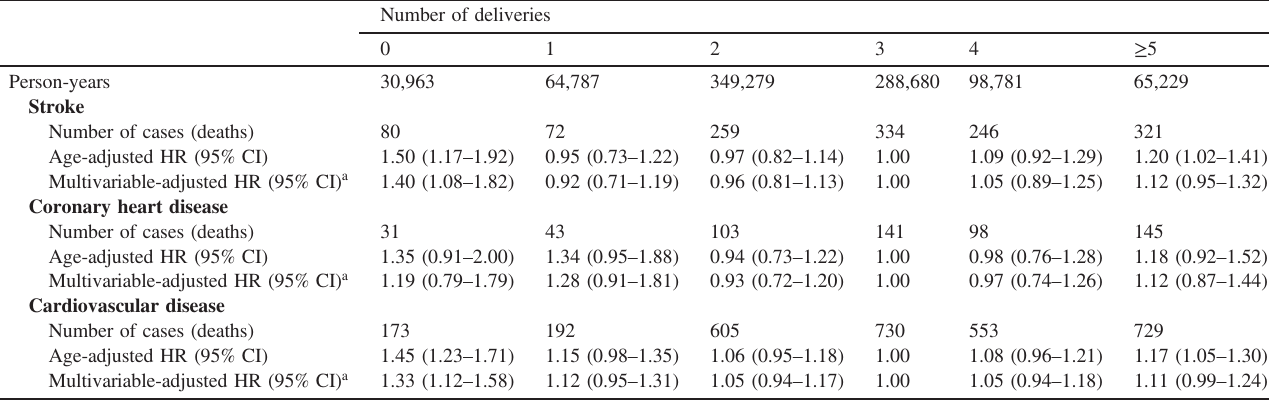
Table 2. Hazard ratios and 95% con fi dence intervals of mortality from cardiovascular disease according to the number of deliveries among women aged 40 – 79 years